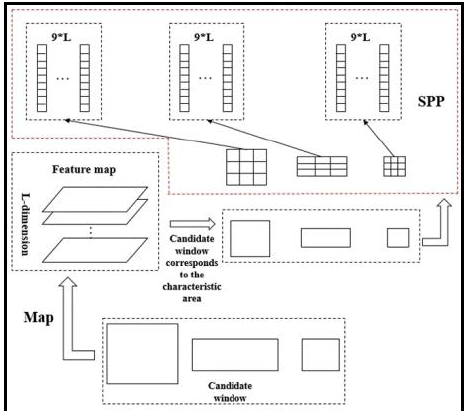
Figure 4. Diagram of SPP. The input is a candidate window. The output is a fixed dimension feature map of candidate window.